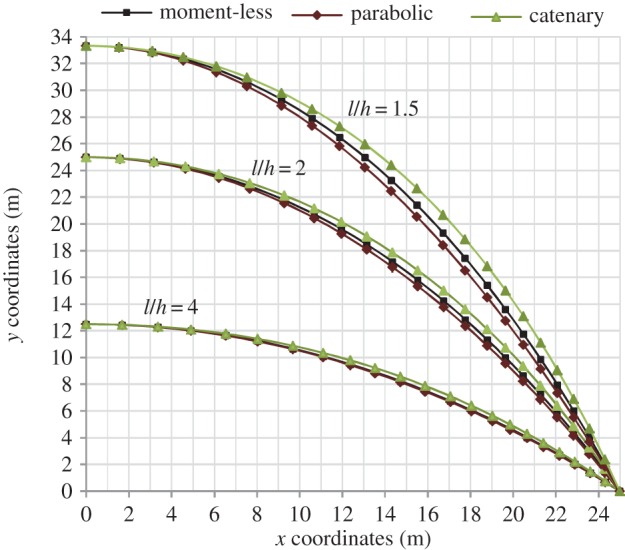
Profiles of moment-less and parabolic arches, respectively, for r=2 and varied l/h ratios. (Online version in colour.)